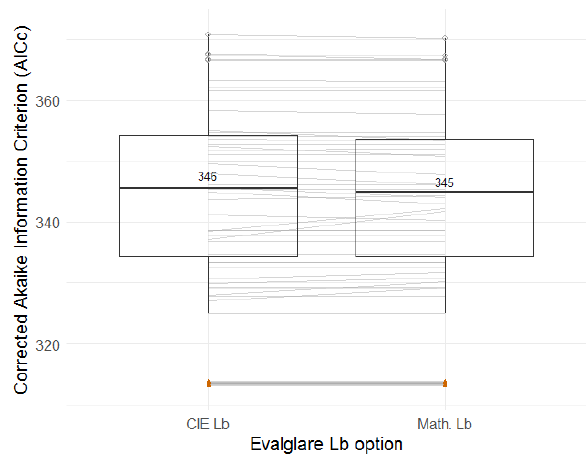
Figure 17. Boxplots of AICc for the two background luminance definitions (laboratory study).